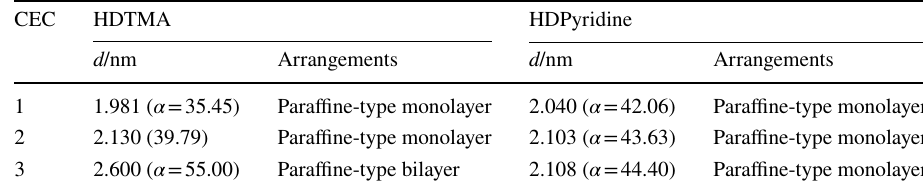
HDTMA, HDPy and different arrangements